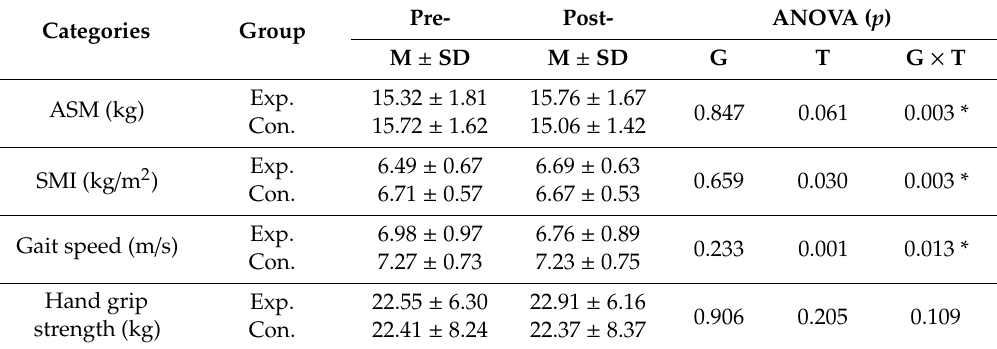
Table 3. E ff ects of augmented-reality-based exercise on muscle parameters for older adults.